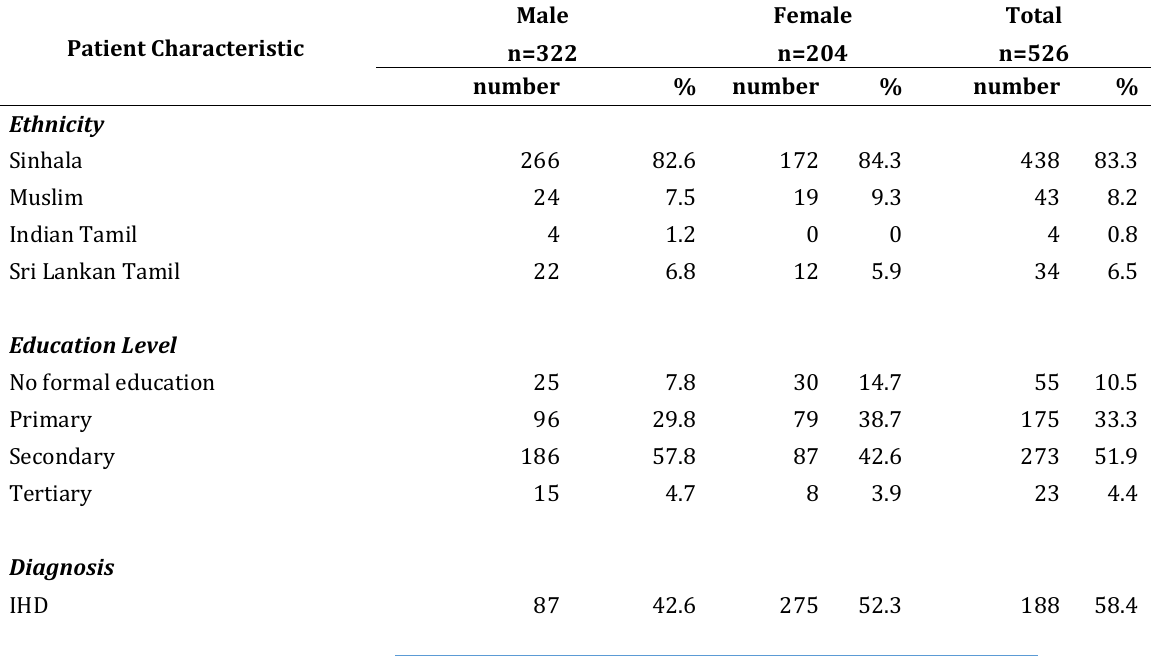
Table 1: Socio-demographic characteristics, body weight categories and presence of central obesity in study